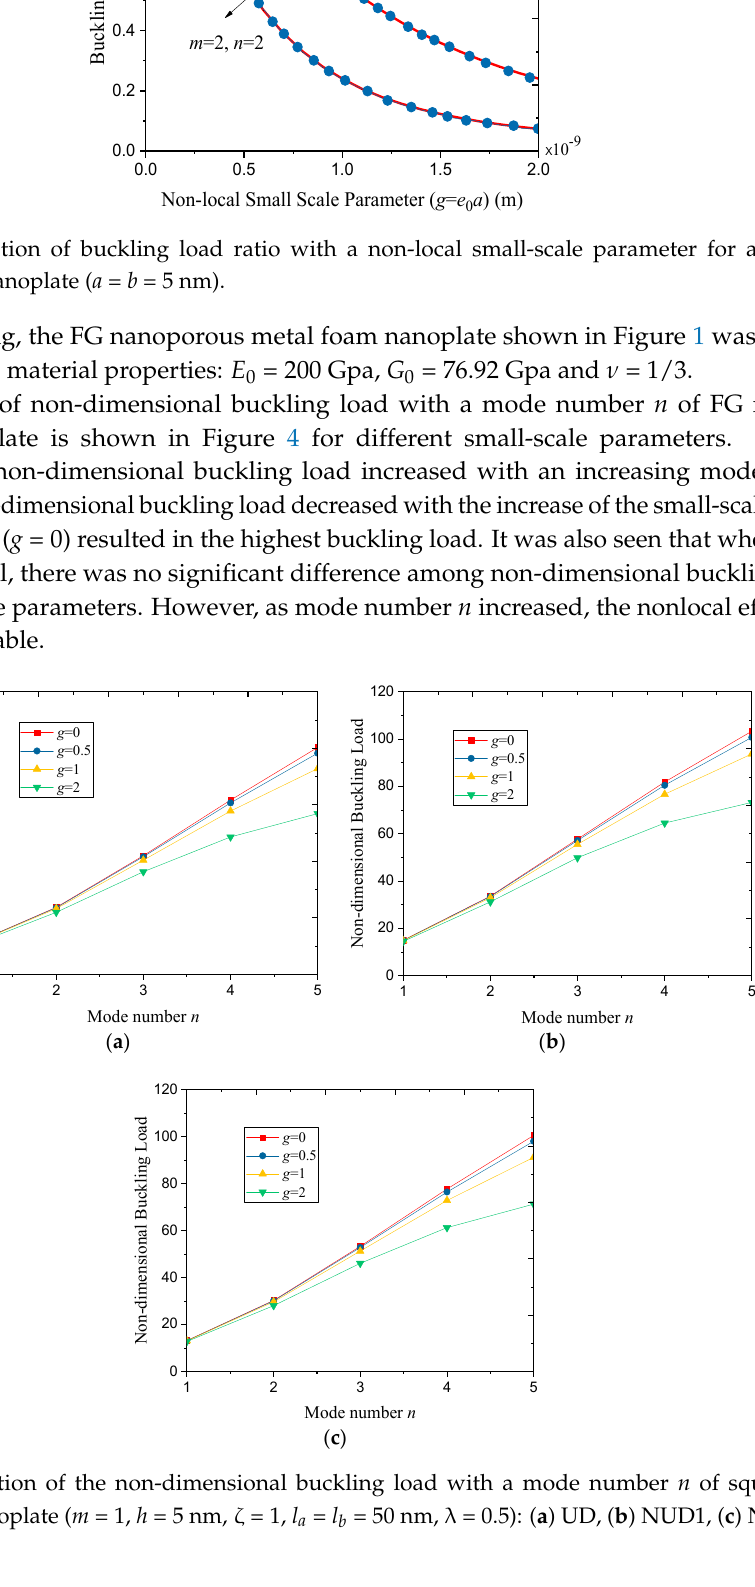
Figure 2. Variation of buckling load ratio with a non-local small-scale parameter for a rectangular homogeneous nanoplate ( m = n = 1, a = 10 nm, b = 5 nm).